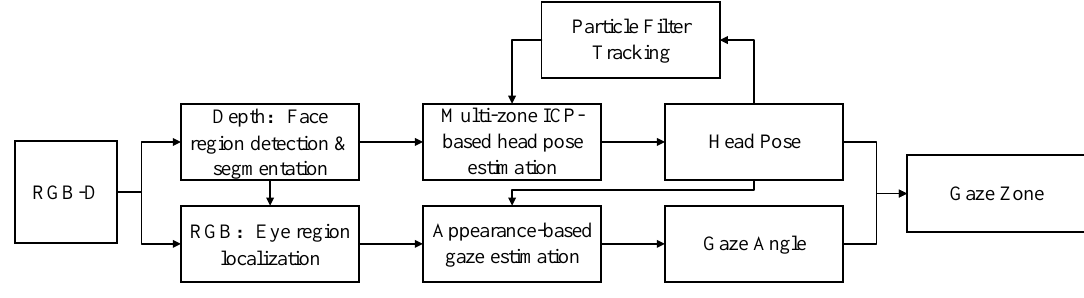
Figure 2. Overview of the proposed